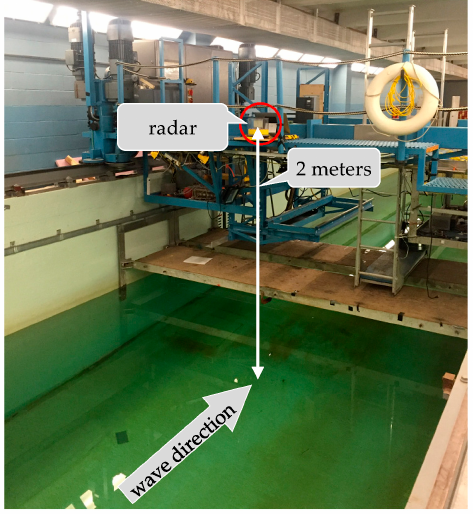
Figure 21. Experimental set-up in wave tank. The radar is fixed on the stationary blue carriage. The radar transceiver is the white square in the center of the red circle. It can rotate to transmit in different directions to adjust the angle to wave, 𝛽 .